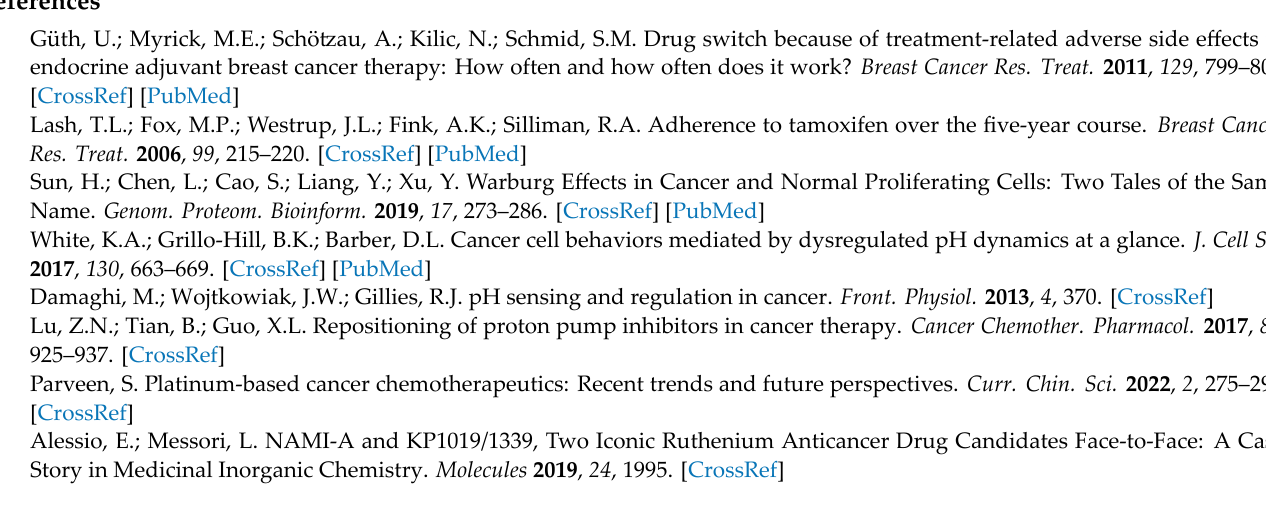
Figure S22: pH‑dependent UV‑vis spectra of benzimidazole; Figure S23: Time‑dependent UV‑vis spectra of the c ([RhCp*(en)(H 2 O)] 2+ ): c (1‑methylimidazole) = 1:2 mixture at pH = 5.94; Figure S24: Kinetics of Py liberation from synthesized complex; Figure S25: Fractions of the formed mixed ligand complexes of 1‑methylimidazole in the pH‑range 5.0–8.0; Figure S26: Fractions of [Ru( p ‑ complex; Figure S27: Comparison of the M–N(monodentate) distances in different [M(arene) (N,N/O)(N)]‑type complexes; Table S1: p K a values of the co‑ordinated water molecules in complexes; Table S2: Formation constants of mixed‑ligand complexes; Tables S3–S5: Experimental data tables for single‑crystal XRD; Tables S6 and S7: MIC values for all compounds, pH =